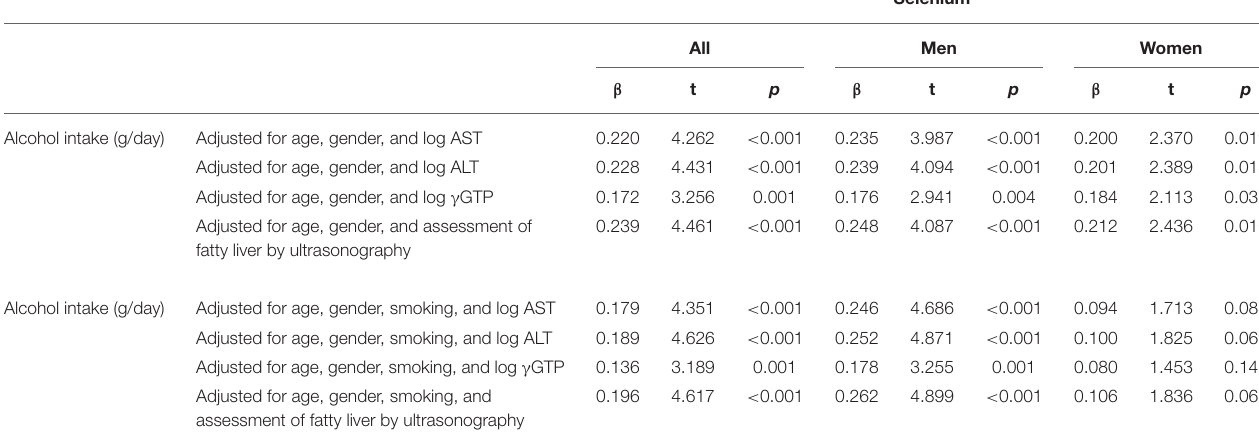
TABLE 3a | Relationship between alcohol intake and selenium in participants taking alcohol.